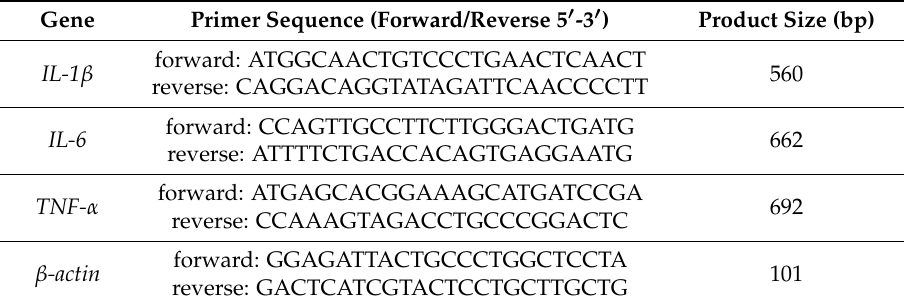
Table 1. Sequence information on the primers used for quantitative PCR. IL—interleukin; TNR—tumor necrosis